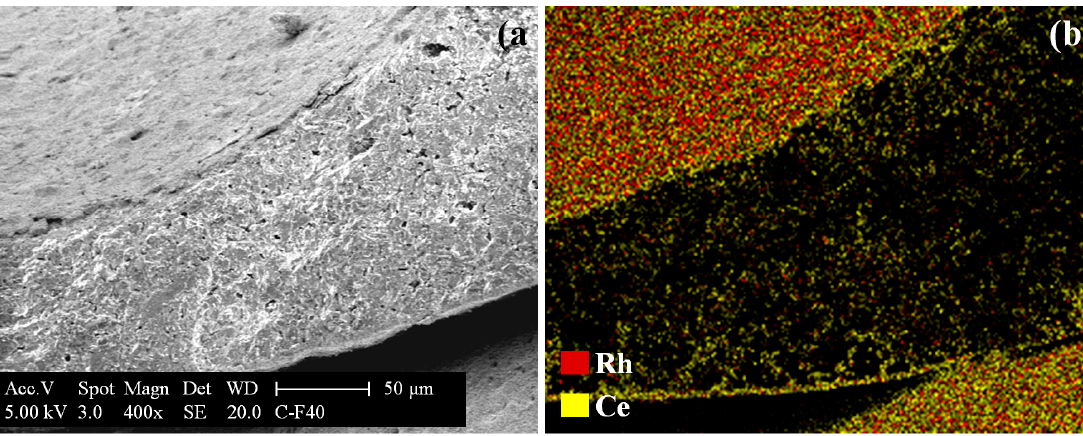
Figure 4. SEM micrographs of the Rh/CeO 2 -coated F40 catalyst: cross section ( a ) and relative EDX mapping ( b